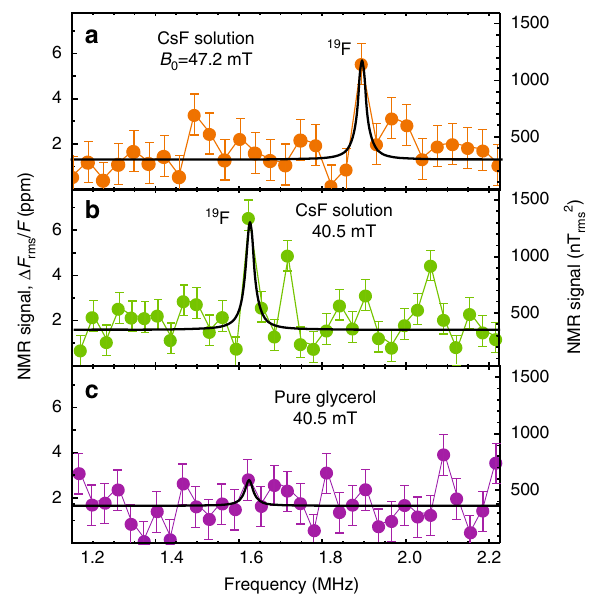
Fig. 5 Solution NMR. a , b NMR spectra of 20% by weight CsF solution in glycerol at 47.2 and 40.5 mT. c NMR spectrum of pure glycerol. All spectra were measured with an XY8-10 correlation spectroscopy pulse sequence tuned to the 19 F precession frequency. Each spectrum was fi t to a single Lorentzian function with central frequency set to the anticipated 19 F Larmor frequency. The linewidth was fi xed to that of the 1 H linewidth in glycerol obtained under similar conditions. The only free fi t parameters were peak amplitude and offset. We assume that each spectrum contains at most one NMR line (from 19 F) and other fl uctuations are due to noise. Error bars represent standard deviation of off-resonant Figure 3b, c shows the time-domain and frequency-domain